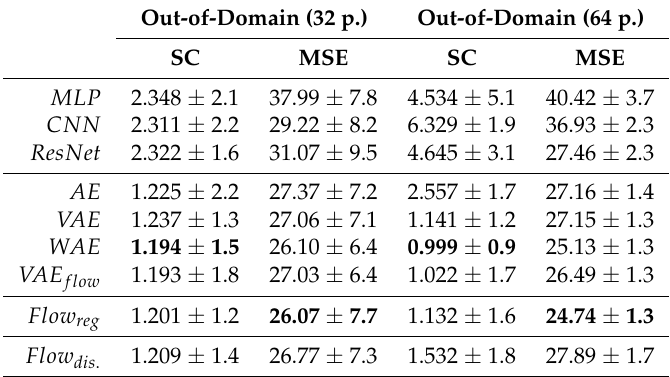
Table 2. Comparison between baselines, *AEs, and our flows on the out-of-domain parameters inference task. We report across-folds mean and variance for parameters (MSE) and audio (SC and MSE) errors. Out-of-Domain (32